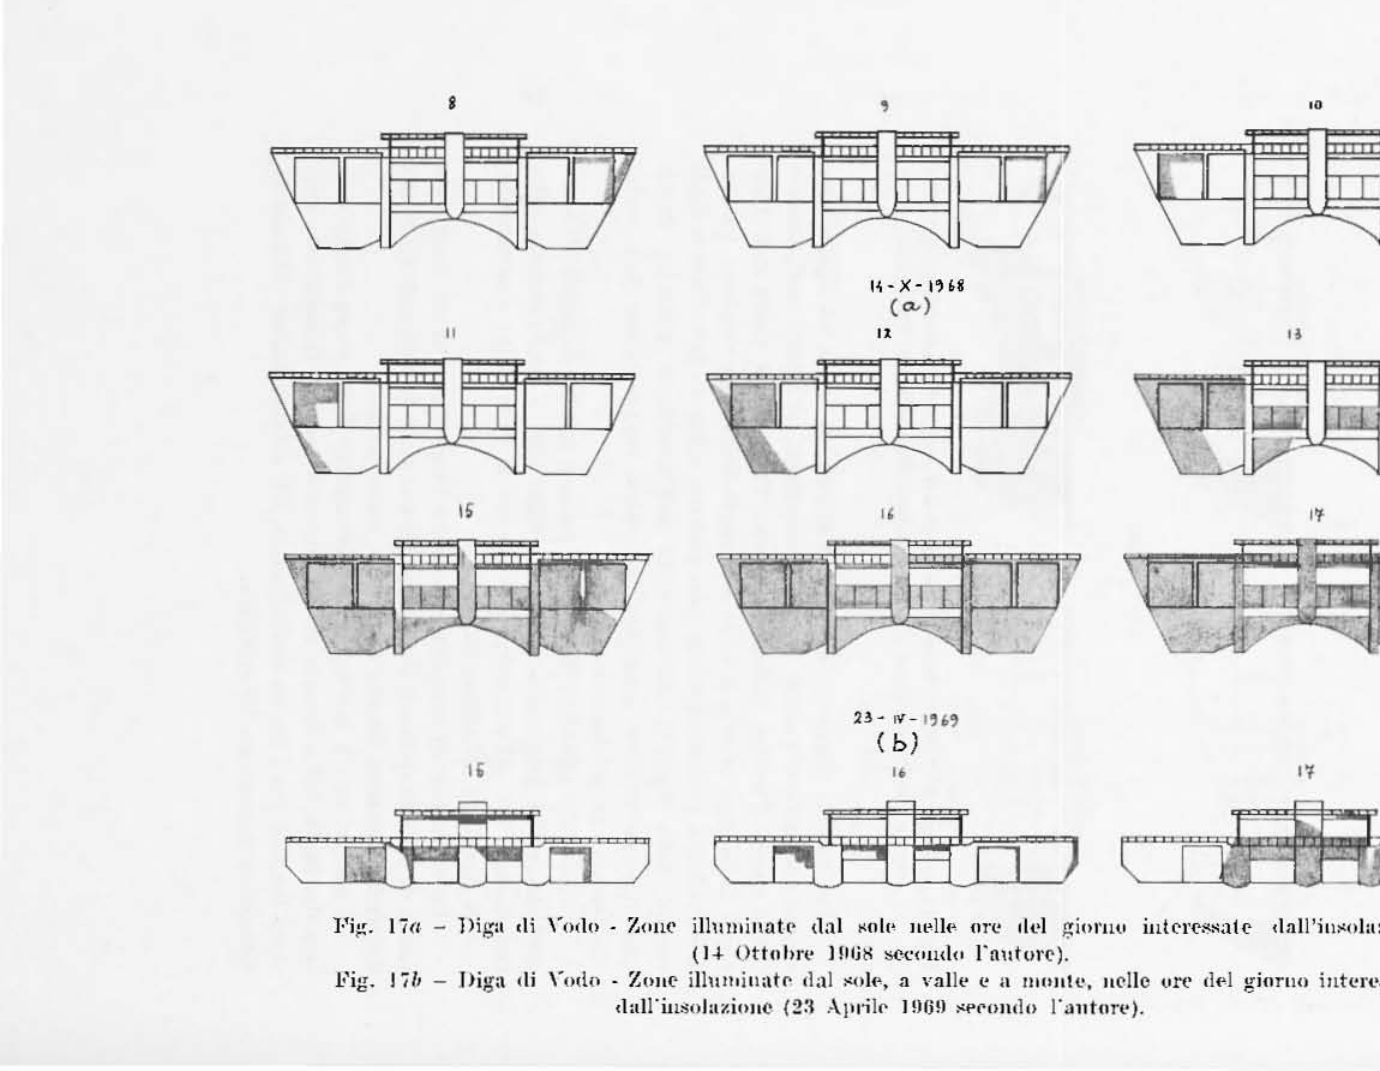
Fig. I ib - Big:1 di '"01\" . ZOIl(' ilhll"jl1;t11' ,];11 >'(,If'. a \"all(' (' a tlw"h.'. ,,<,Ile un' df'l giurno